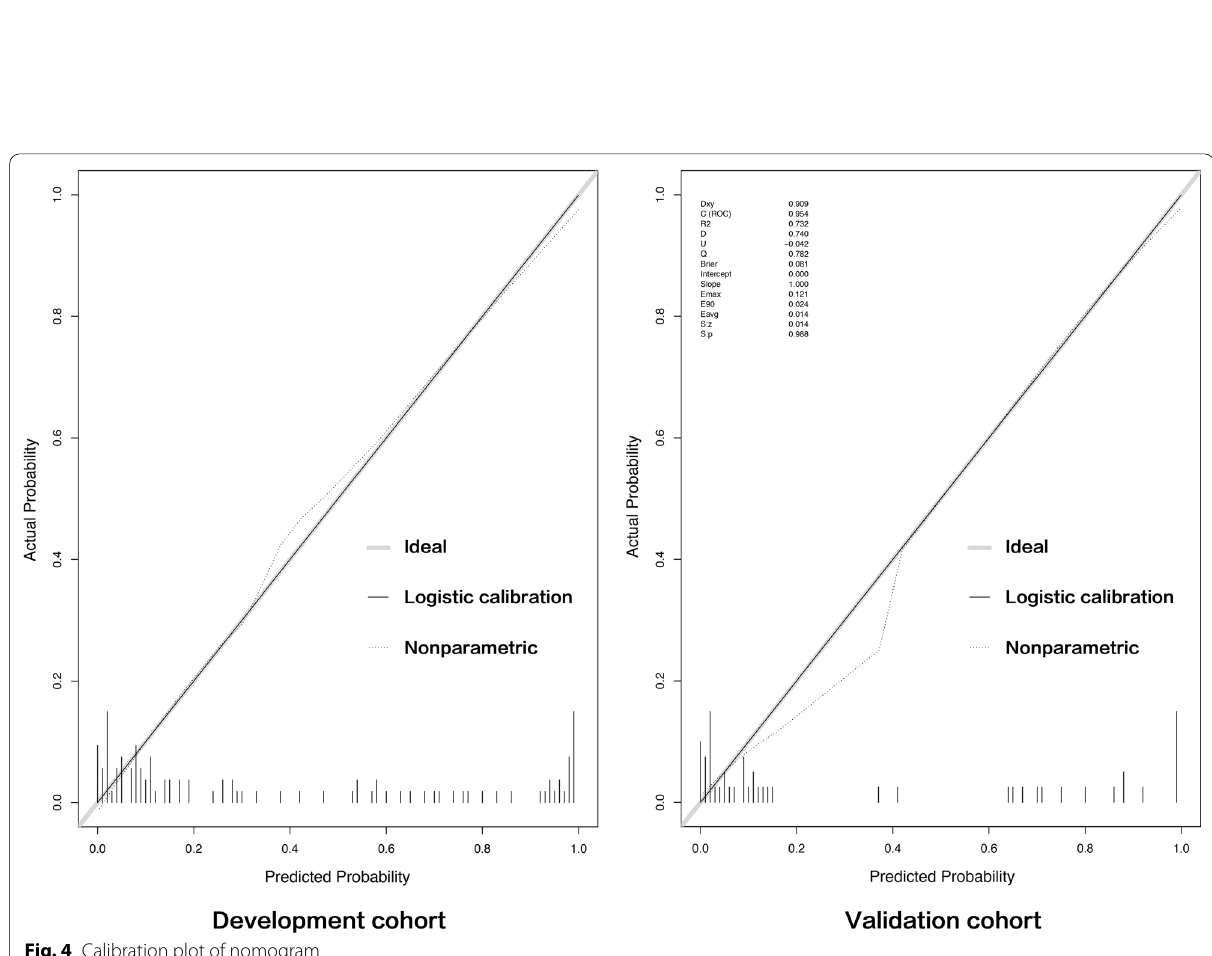
Fig. 3 The nomogram for patients with non‑LAA‑type AIS. To use the nomogram, an individual patient’s value is located on each variable axis, and a line is drawn upward to determine the number of points received for each variable value. The sum of these numbers is located on the Total Points axis, and a line is drawn downward to the survival axes to determine the likelihood of poor outcome